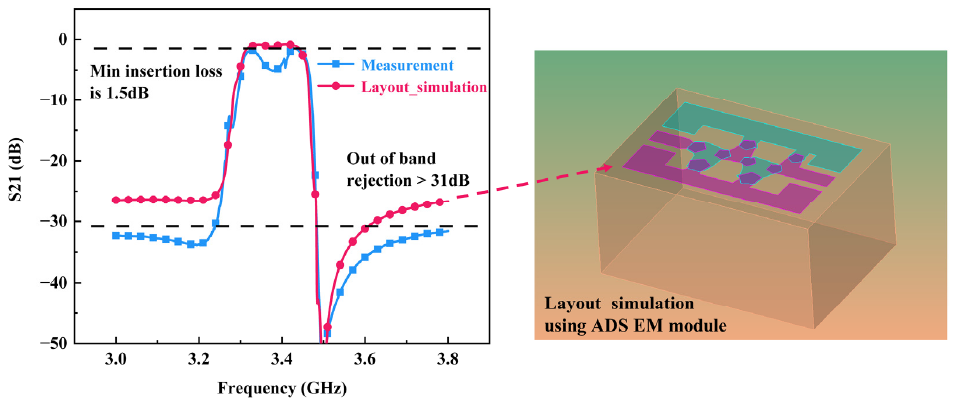
Figure 8. Comparison of the S21 spectra of the filter obtained by layout simulation and measurement. Table 2. Comparison with prior BAW resonators and related